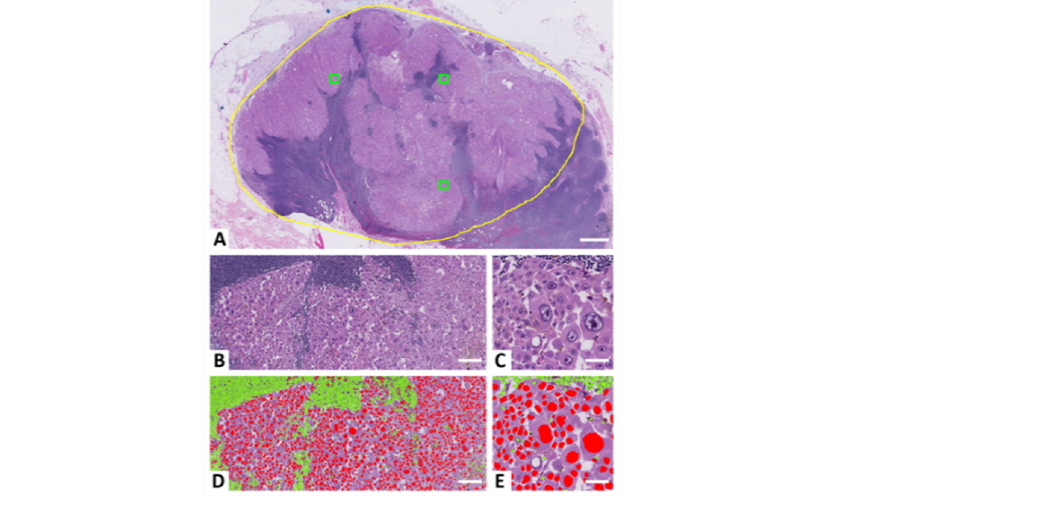
Figure 1. H&E-stained lymph-node melanoma metastasis. The pathologist’s eyeballed tumor burden was 70%; yet, the mutant-allele frequency of next-generation sequencing was 10%. The large difference in nuclei size between normal and tumor cells may have caused the difference, in addition to inaccuracies related to the technician’s manual macrodissection of the tumor. ( A ) Tumor outline (yellow) used for tumor burden calculation and macrodissection, including 0.05 mm 2 squares (green) of systematic-random sampling, which were used to compare and evaluate study procedures; scalebar 1000 µm. ( B , C ) Large melanoma cells and small normal cells; mostly lymphocytes. ( D , E ) Automated nuclei detection and calculation of tumor burden by convolutional neural network; scalebars 125 µm and 50 µm, respectively.